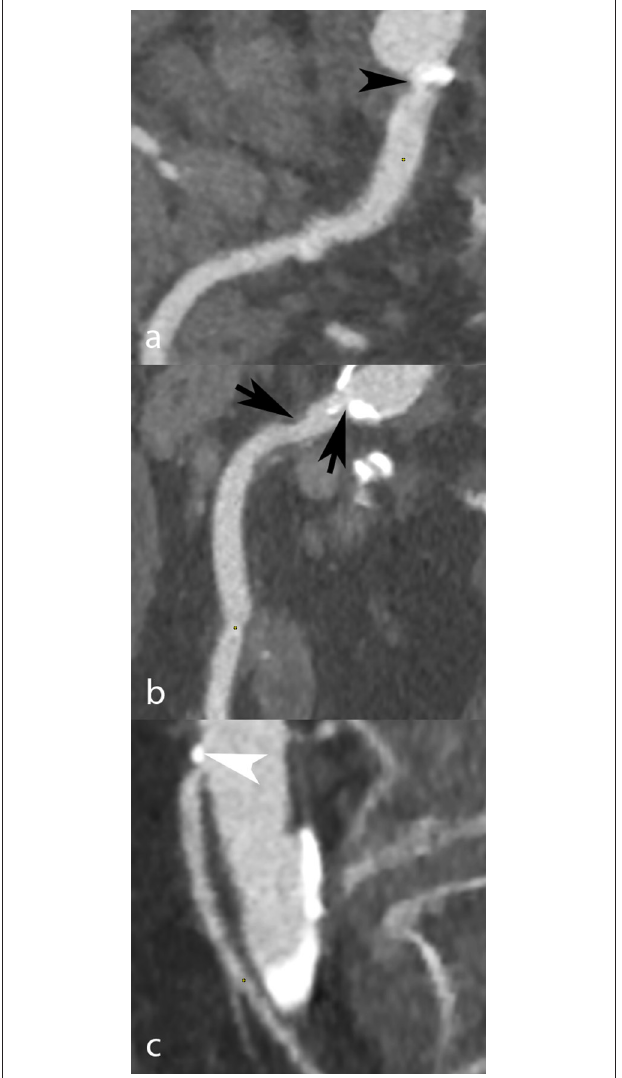
FIGURE 2 | CT angiography in a 90-year-old woman scheduled to undergo TAVI. Curvilinear reconstructions show the coeliac trunk (a) , superior (b) , and inferior mesenteric artery (c) . All three arteries had significant ostial occlusive disease, due to mixed plaques at the coeliac (black arrowhead) and inferior mesenteric (white arrowhead) arteries’ ostium, and to a mixed ostial plaque associated with a non-calcified post-ostial plaque (black arrows) in the superior mesenteric artery.